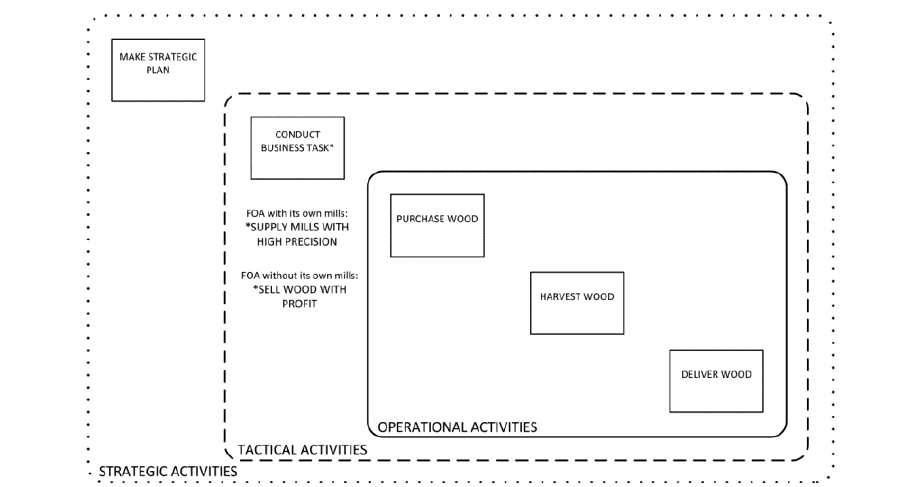
Figure 5. General functions in the forest owners associations (FOAs), with a principal division of functions containing strategic, tactical and operational activities. The Conduct business task functions were different for the two FOAs, and their respective tasks are stated under the activity box (marked with